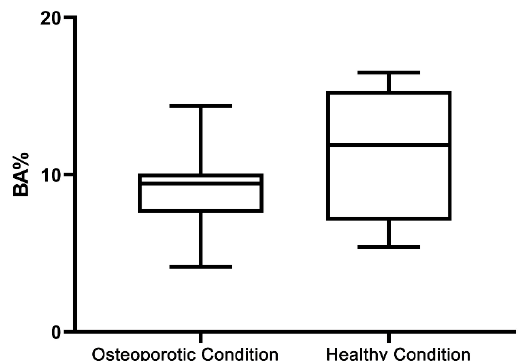
Figure 6. Box-and-whisker plot shows the histomorphometric bone area (BA%) in saline groups in both osteoporotic and healthy conditions.